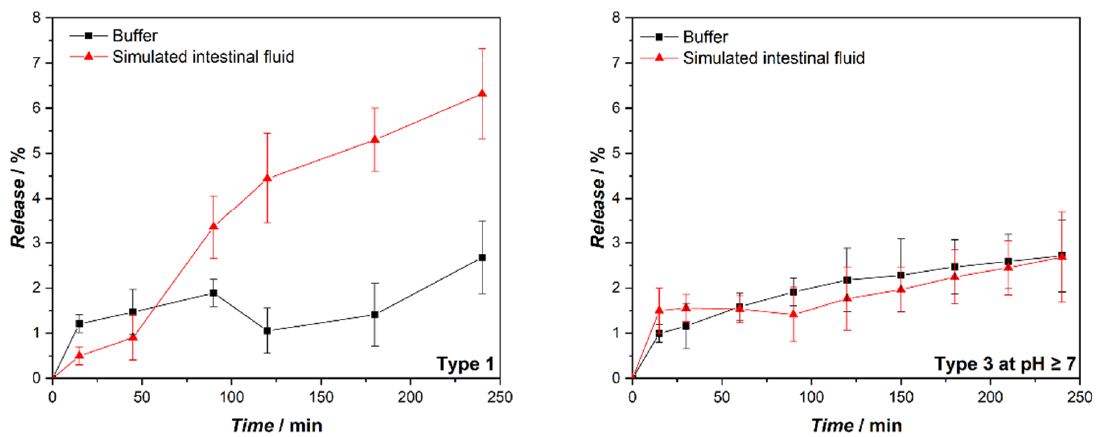
Figure 6. Comparison between the calcein release from liposomes of Type 1 and Type 3 (pH ≥ 7) when incubated in the simulated intestinal fluid (pH = 7.4) and K-phosphate buffered saline (PBS) solution (pH = 7.4). During the simulated intestinal digestion liposomes of Type 2 and 3 are equal since the EuS100 dissolves in these conditions. The error bars represent the standard deviations of the experiments ( n = 3).